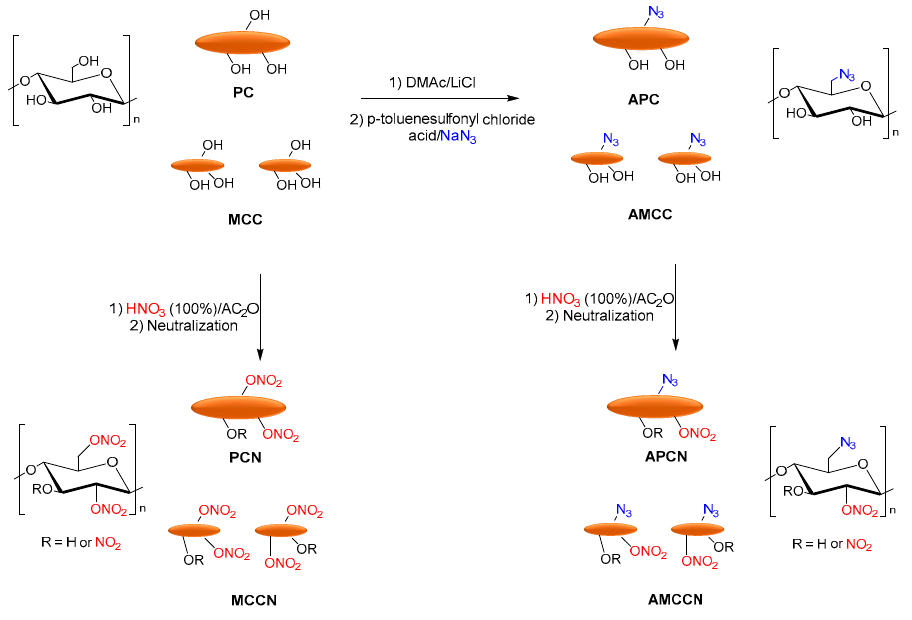
Figure 12. Synthesis of PCN, MCCN APCN, and AMCCN.